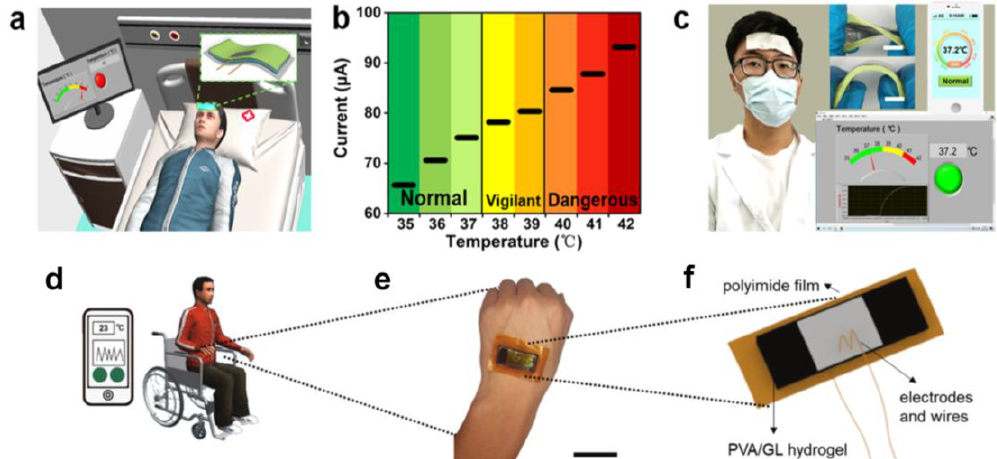
Figure 15. Application demonstration of wearable medical electronics. ( a ) Panoramic view of the gel-based thermoelectric patch for body temperature monitoring. ( b ) Relationship between current and body temperature in the three typical regions. ( c ) Body temperature monitoring and the corresponding temperature signal displayed on terminals. Inset: photographs of the gel patch that was twisted and bent (scale bar: 1 cm). (Reproduced with permission from [118]. Copyright 2021 American Chemical Society). Application demonstration of self-powered temperature monitoring using the PVA/GL thermogalvanic hydrogel. ( d ) Panoramic view of the gel-based patch for ambient temperature monitoring. ( e ) Photograph of a gel patch worn on the back of the hand. Scale bar (5 cm). ( f ) Schematic diagram of PVA/GL gel patch. (Reproduced with permission from [121]. Copyright 2022 Royal Society of Chemistry).